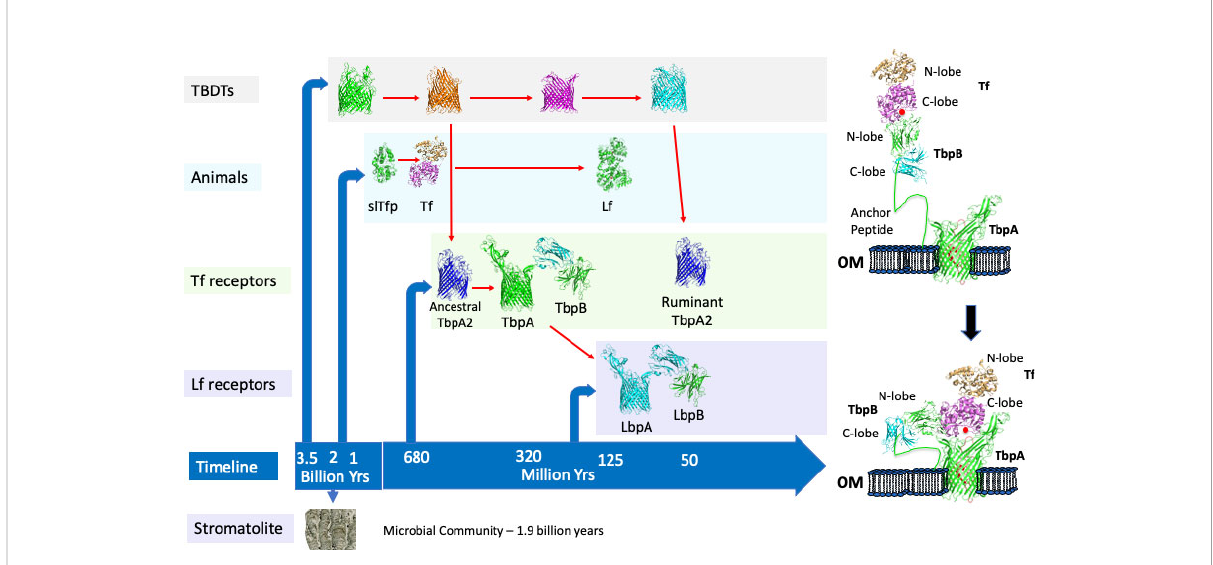
FIGURE 1 The evolution of iron acquisition systems in bacteria and multicellular animals. The timeline for appearance of microbial communities (stromatolite), proteins involved in acquisition of iron by Gram-negative bacteria (TBDTs, Tf receptors, Lf receptors) and in multicellular animals is illustrated in the left panel. Red arrows indicate evolutionary ancestors. The process for capture and iron removal from the two-component receptor is illustrated in the right